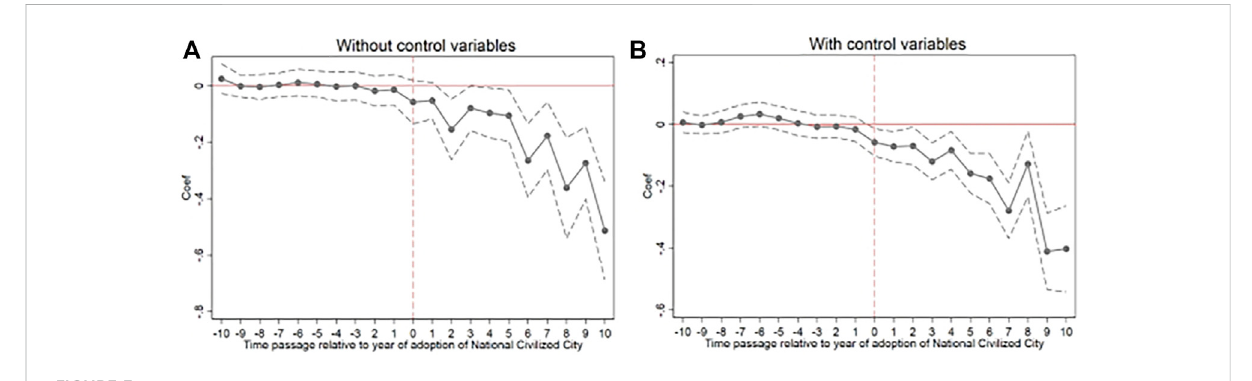
FIGURE 3 Parallel trend test. (A) Without control variables, (B) With control